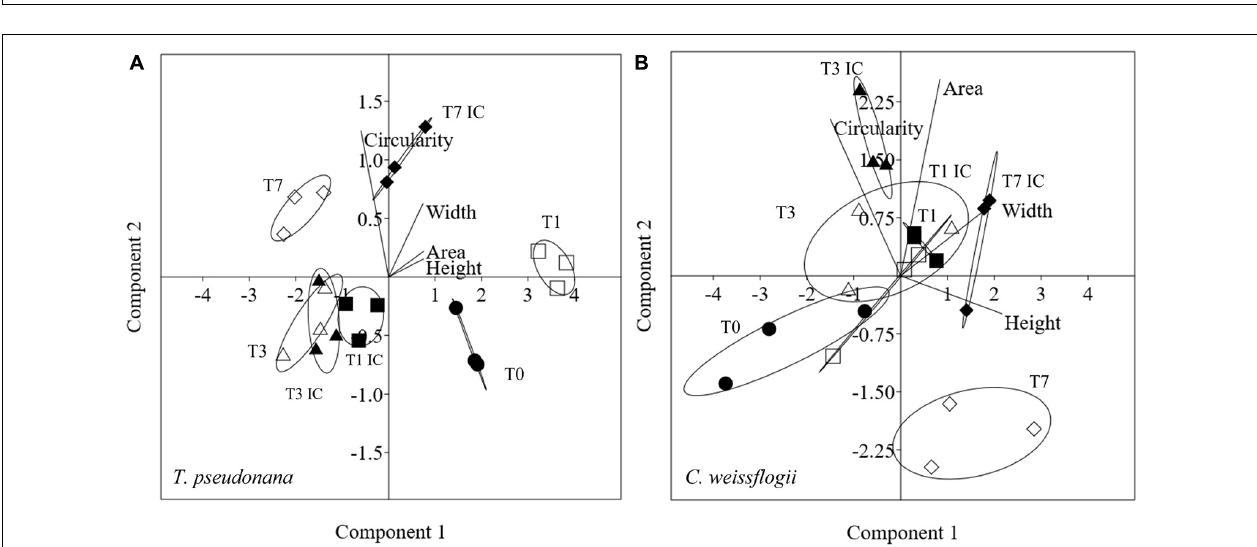
FIGURE 3 | Comparison between growth curves of the centric diatom mix exposed (A) or not (B) to copepods. The data are means of 3 biological replicas. Error bars show SD while letters indicate significant differences according to two-way ANOVA followed by Tukey’s post-hoc test, p < 0.05 ( Supplementary Table 11 ).